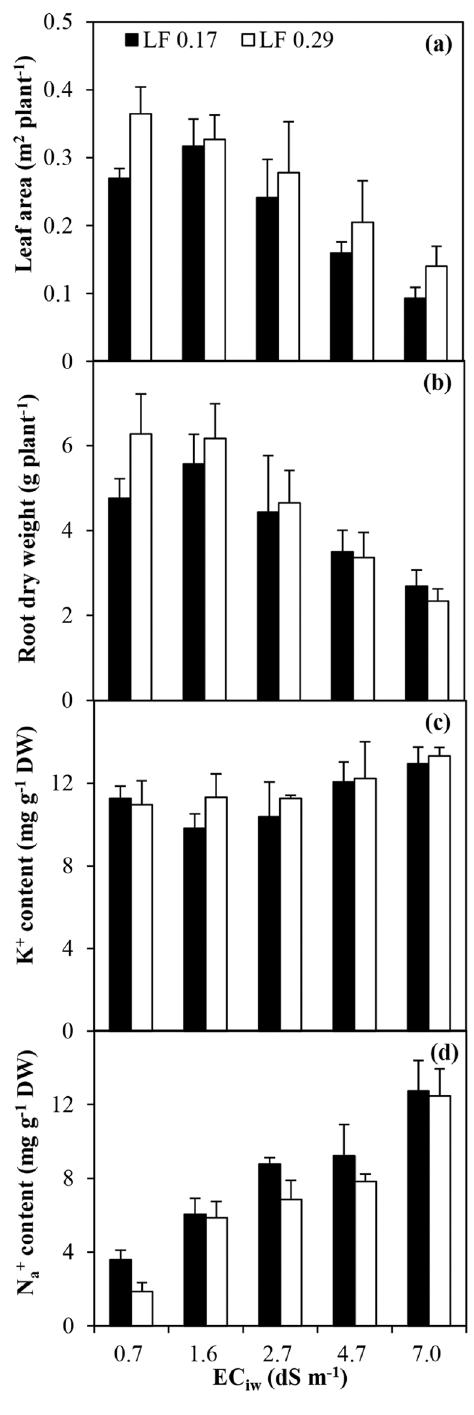
Figure 7. Leaf area ( a ), root dry weight ( b ) and K + ( c ) and Na + ( d ) concentrations of roots under various irrigation water salinity levels (EC iw ) and leaching fractions (LF). The error bars indicate standard